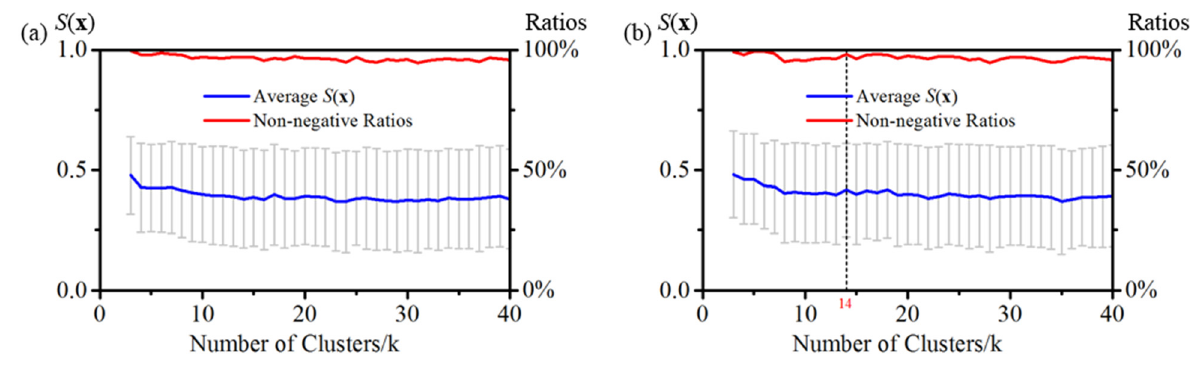
Figure 1. Averaged silhouette values and non-negative ratios of silhouette values based on clustering results of: ( a ) M-Cluster; ( b )